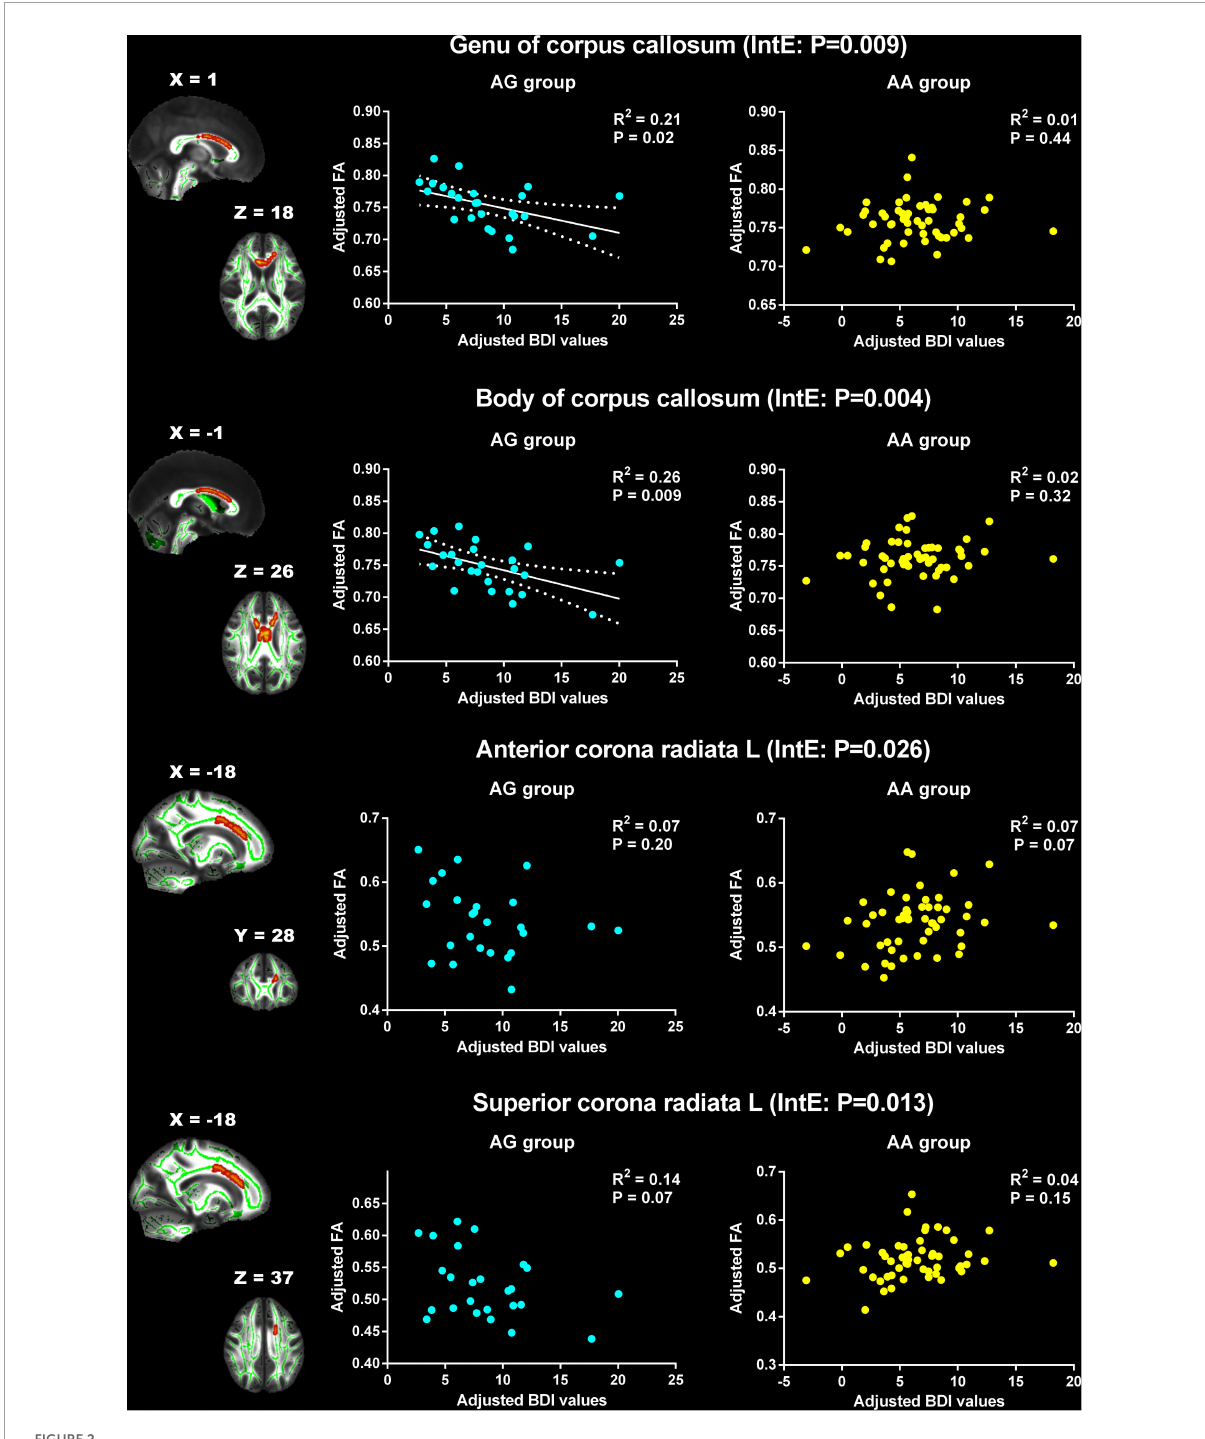
FIGURE2 Significant effects of PER1 genotypes on the associations between BDI values and FA. The significant interaction effects of genotypes × BDI were observed in the white matter tracts of genu of corpus callosum, body of corpus callosum, the left anterior corona radiata and the left superior corona radiata. The adjusted BDI and FA were the measures after removing the ten covariates. For the convenience of showing interaction effect, we averaged the adjusted BDI and FA among the voxels in the above WM tracts, and performed the correlation analysis between the adjusted BDI value and FA of WM tracts in each group. BDI the Beck Depression Inventory; FA fractional anisotropy; L left. The blue dot represents the AG group; the yellow dot represents the AA group. InE interaction effects. The white solid line represents the linear regression of the